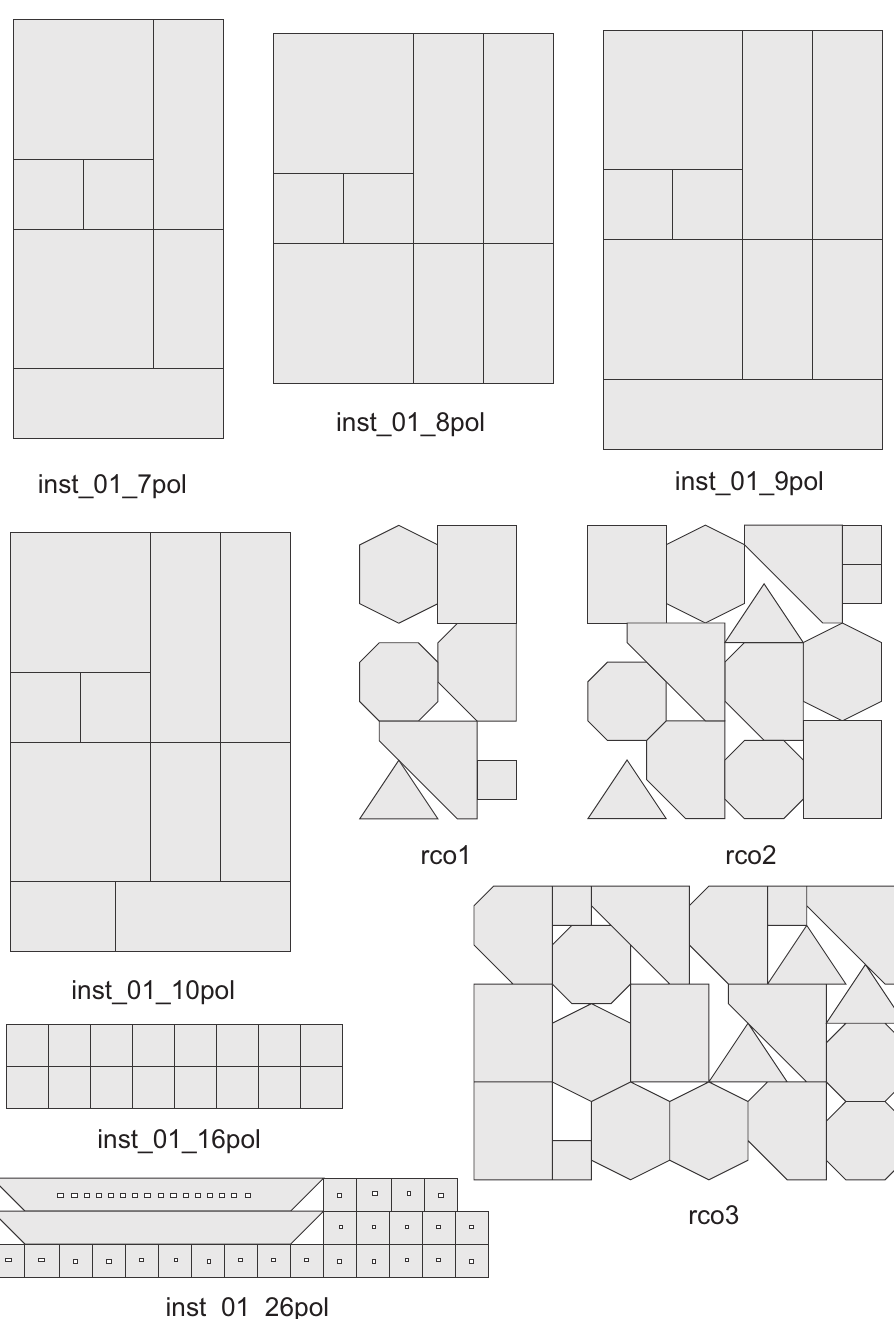
Figure A2. Second batch of instances with connected